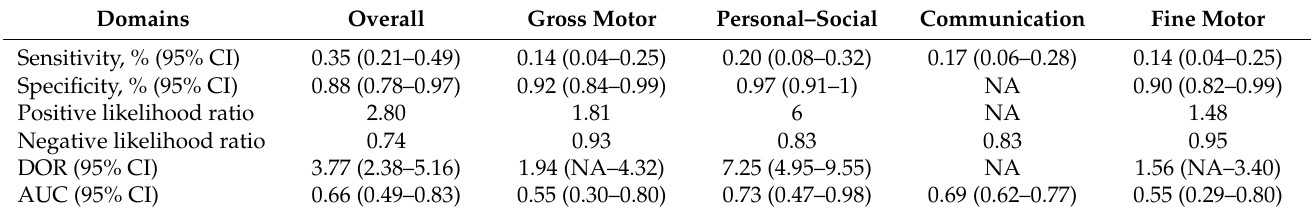
Table 4. Subgroup analysis of the classification performance of the Ages and Stages Questionnaire—Third Edition in children with low maternal education level.